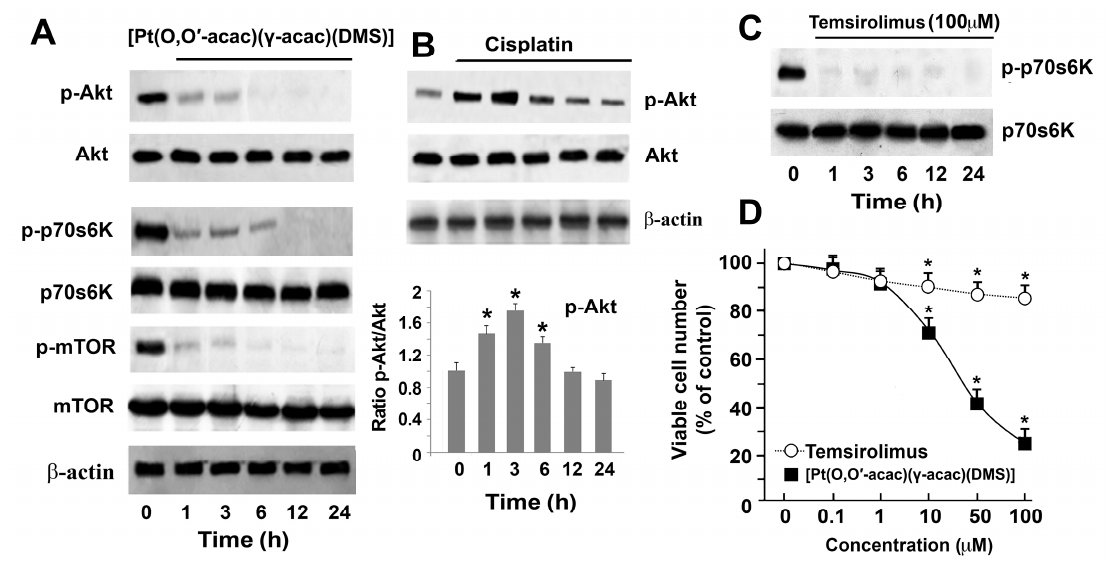
Figure 5. [Pt( O , O (cid:48) -acac)( γ -acac)(DMS)] induces autophagy through inhibition of the phosphatidine 3-kinase (PI3K)/AKT-mTOR pathway. ( A ) Cell lysates obtained from Caki-1 cells treated with 10 µ M [Pt( O , O (cid:48) -acac)( γ -acac)(DMS)], for the indicated times, were subjected to Western blotting analyses with monoclonal antibodies specific to p-p70S6K, p70S6K, p-mTOR, m-TOR, p-AKT, and AKT. ( B ) (Up) Cell lysates from cells treated with 50 µ M cisplatin, for the indicated times, were subjected to Western blotting analyses with monoclonal antibodies specific to p-AKT and AKT. Sequential incubation with anti- β -actin confirmed the equal protein loading. These figures are representative of six independent experiments. (Down) Densitometric analysis of p-AKT (normalized respectively to total AKT). ( C ) Caki-1 cells were treated, or not, with 100 µ M temsirolimus for the indicated times and cell lysates were analyzed by Western blotting using antibodies specific to p-p70S6K and total p70S6K. The figure is representative of three independent experiments. ( D ) Caki-1 cells were treated, or not, with different concentrations of [Pt( O , O (cid:48) -acac)( γ -acac)(DMS)] or temsirolimus for 24 h, and cell viability was monitored by MTT assay. * p < 0.001 between treated and untreated cells by Student’s t -test ( n =